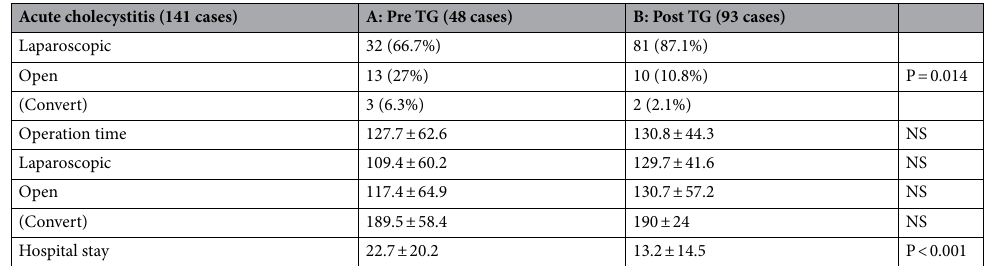
Table 2. Procedure of cholecystectomy and hospital stay. There were significant differences between the two groups regarding the type of surgery performed (P = 0.014). Hospital stay was significantly shorter in groups B, as compared with group A (P < 0.001).